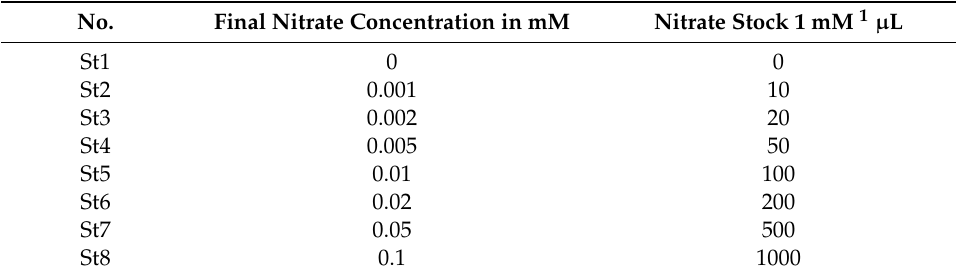
Table A3. Preparation of standards for nitrate